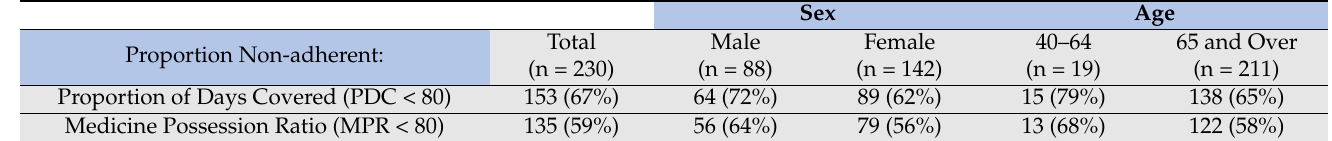
Table 1. Age and sex characteristics of the non-adherence subgroups of all patients with prescription data analyzed in the study (n =